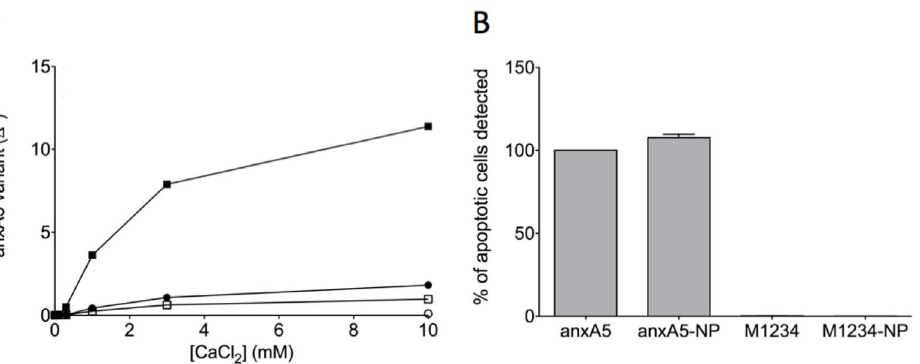
Figure 3. Binding of annexin-variants to phosphatidylserine containing membranes. Panel A shows calcium-dependent binding of anxA5 (closed circles), M1234 (open circle), anxA5-NP (closed squares) and M1234-NP (open squares) to a synthetic phospholipid surface comprising 20 mole% phosphatidylserine and 80 mole% phosphatidylcholine. Binding was measured by ellipsometry and is expressed as change in degree of the analyser ( D u ) as described elsewhere [24]. Panel B shows the % of apoptotic cells of a population of anti-Fas stimulated Jurkat cells that can be detected using fluorescently labeled annexin-variants and flow cytometry.